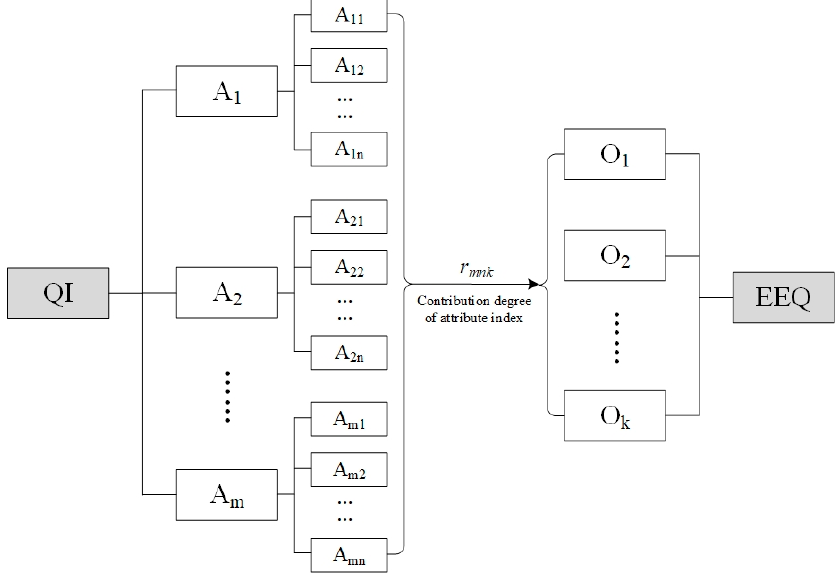
Figure 1. Coupling structure of a "“attribute–object” pattern between QI and EEQ.